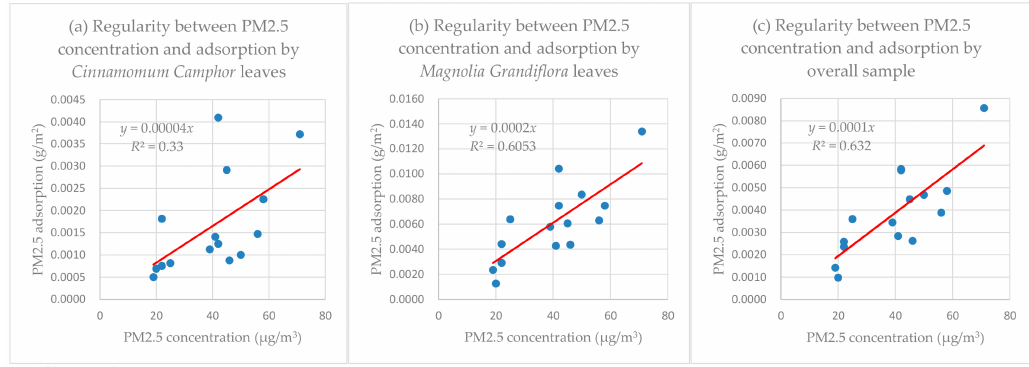
Figure 2. Regularities between PM 2.5 concentration and adsorption by leaves.